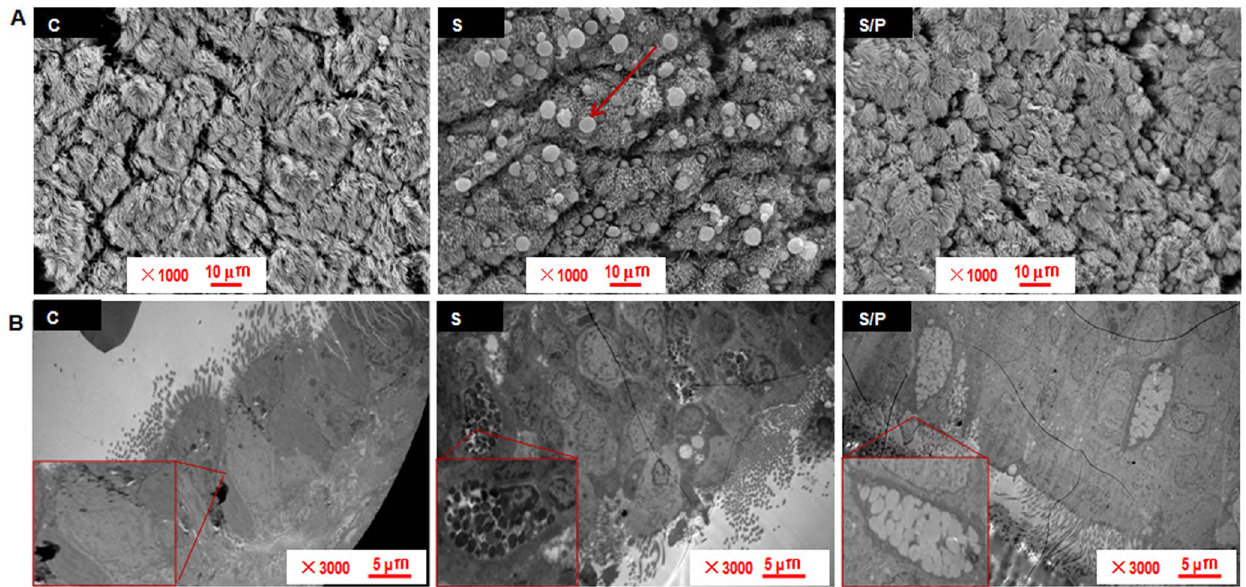
Figure 7. Chronic administration of propranolol inhibits airway goblet cell metaplasia and mucin hypersecretionin in rats exposed to CS. (A) Scanning electron microscopy of the luminal surface shows the apices of ciliated and goblet cells (arrow). Bar=10 m m. (B) Transmission electron microscopy of airway epithelia shows massive mucin-containing secretory granules in goblet cells in response to CS. Bar=5 m m.